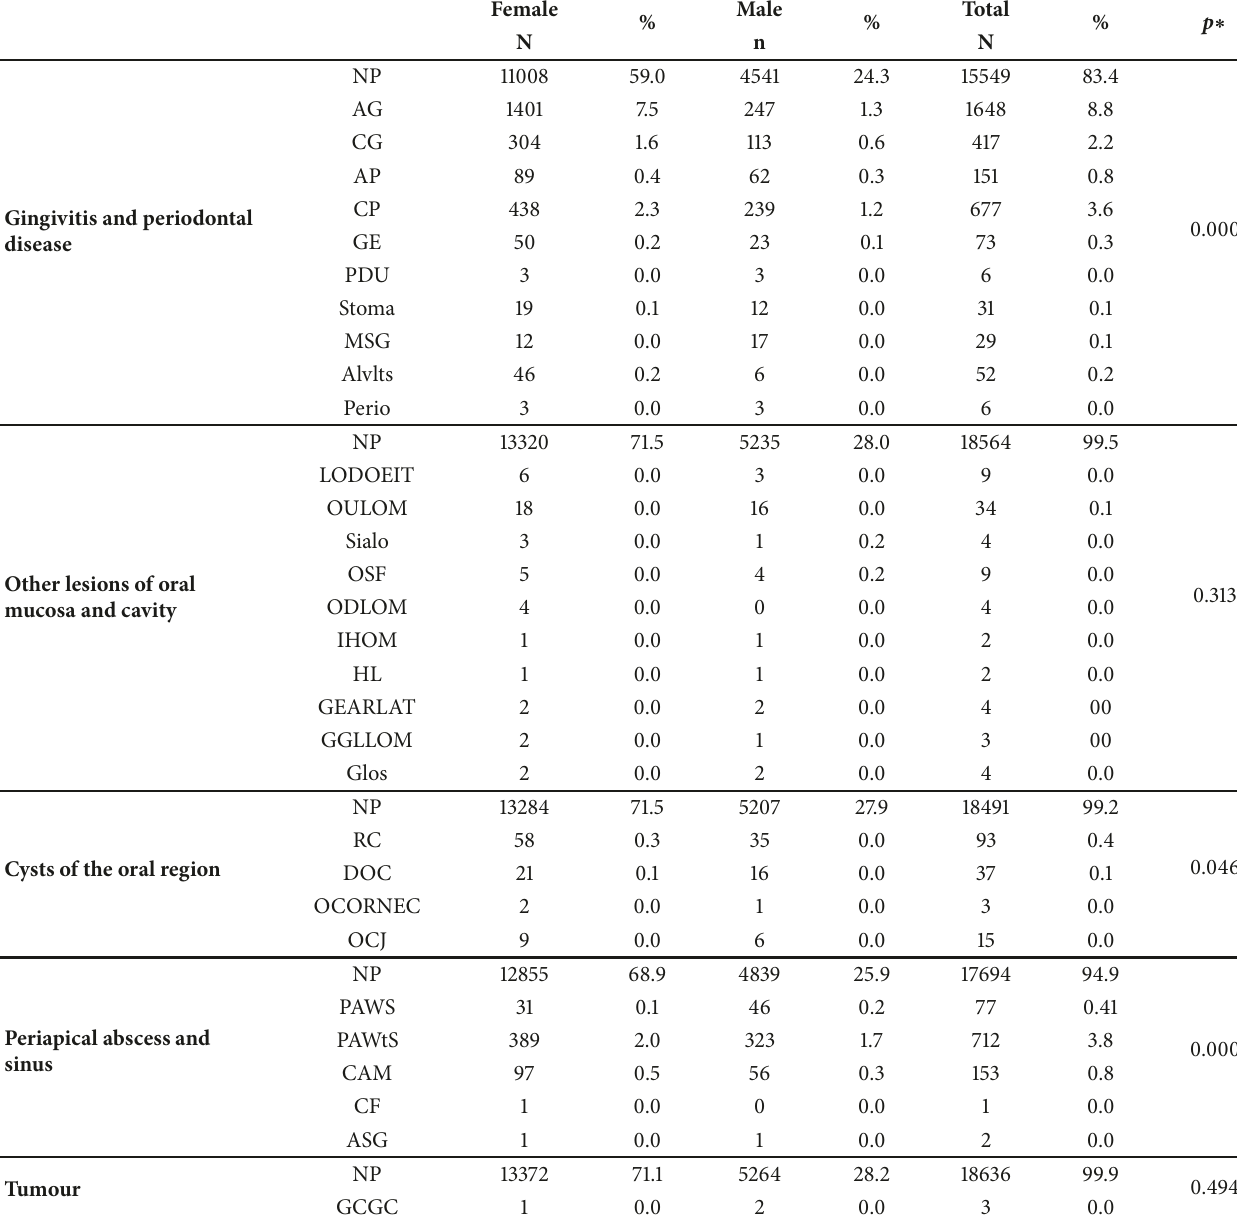
Table 4: Nine-year retrospective study of the prevalence of oral pathologies (soft